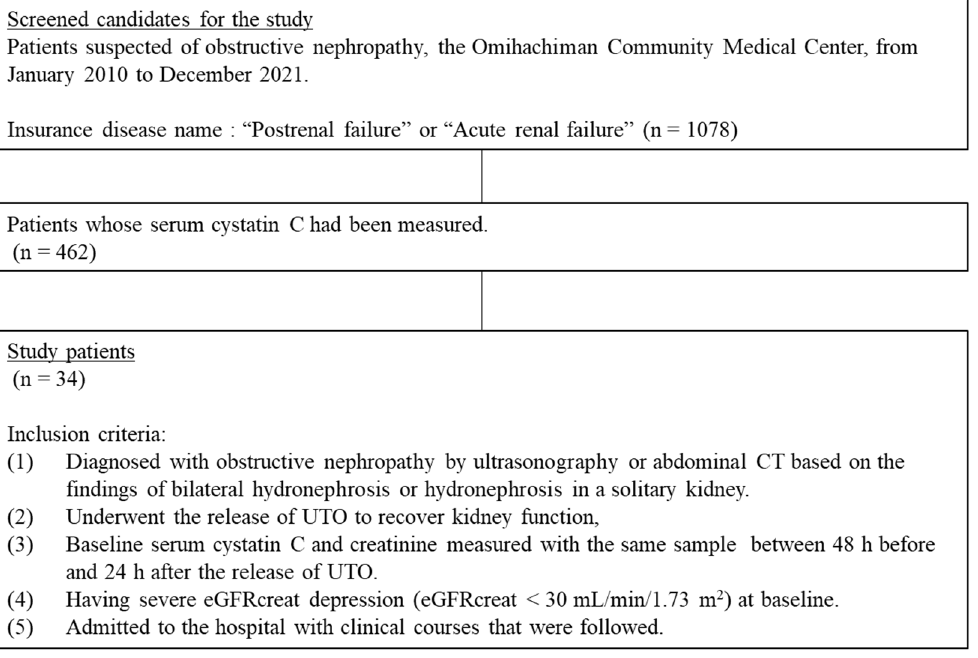
Figure 1. Flow diagram for the inclusion of study patients. Patients with severe obstructive nephrop- athy admitted to the Omihachiman Community Medical Center in Japan between January 2010 and December 2021 were enrolled. Overall, 34 patients, 20 of whom were male, were eligible for inclu- sion in this study. UTO, urinary tract obstruction; eGFRcreat, estimated glomerular filtration rate calculated with serum creatinine.